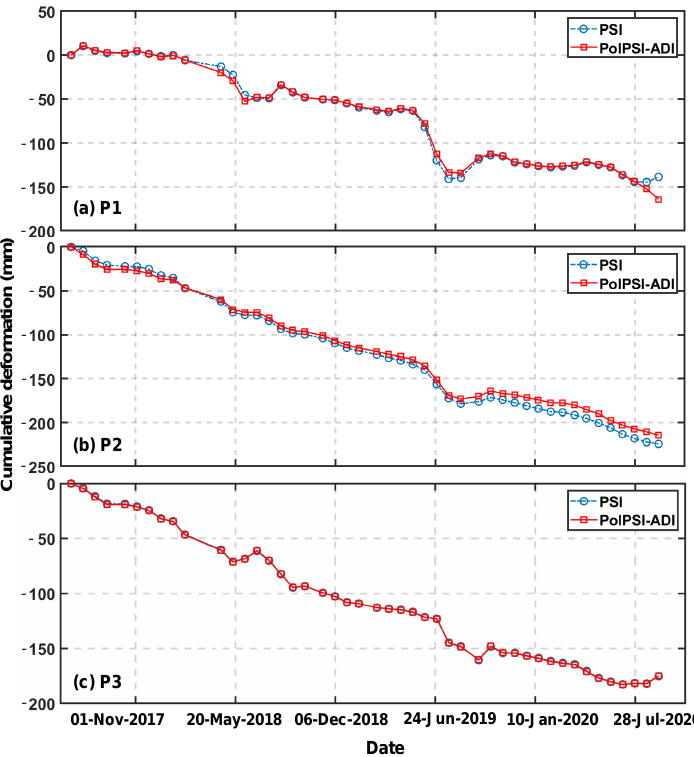
Figure 8. ( a – c ) shows the ground deformation time-series retrieved by PSI and PolPSI-ADI of the three selected pixels P1, P2, and P3 over Beijing test sites, respectively. The locations of P1, P2, and P3 are highlighted by the three white circles in Figure 6a.